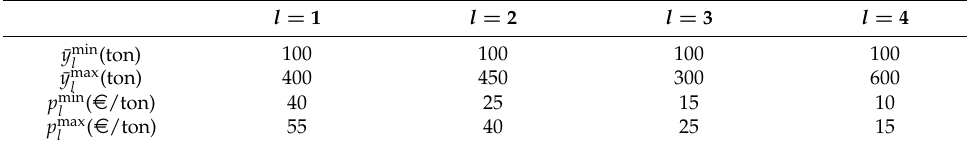
Table 3. The values of the orders and price